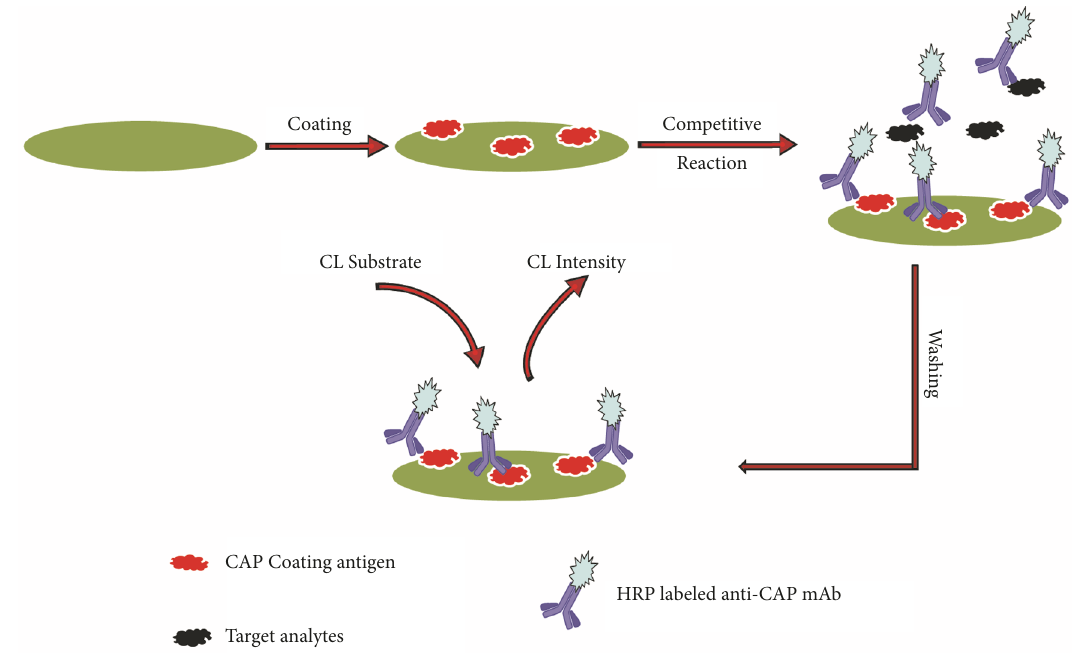
Figure 2: Schematic of the CL-ELISA